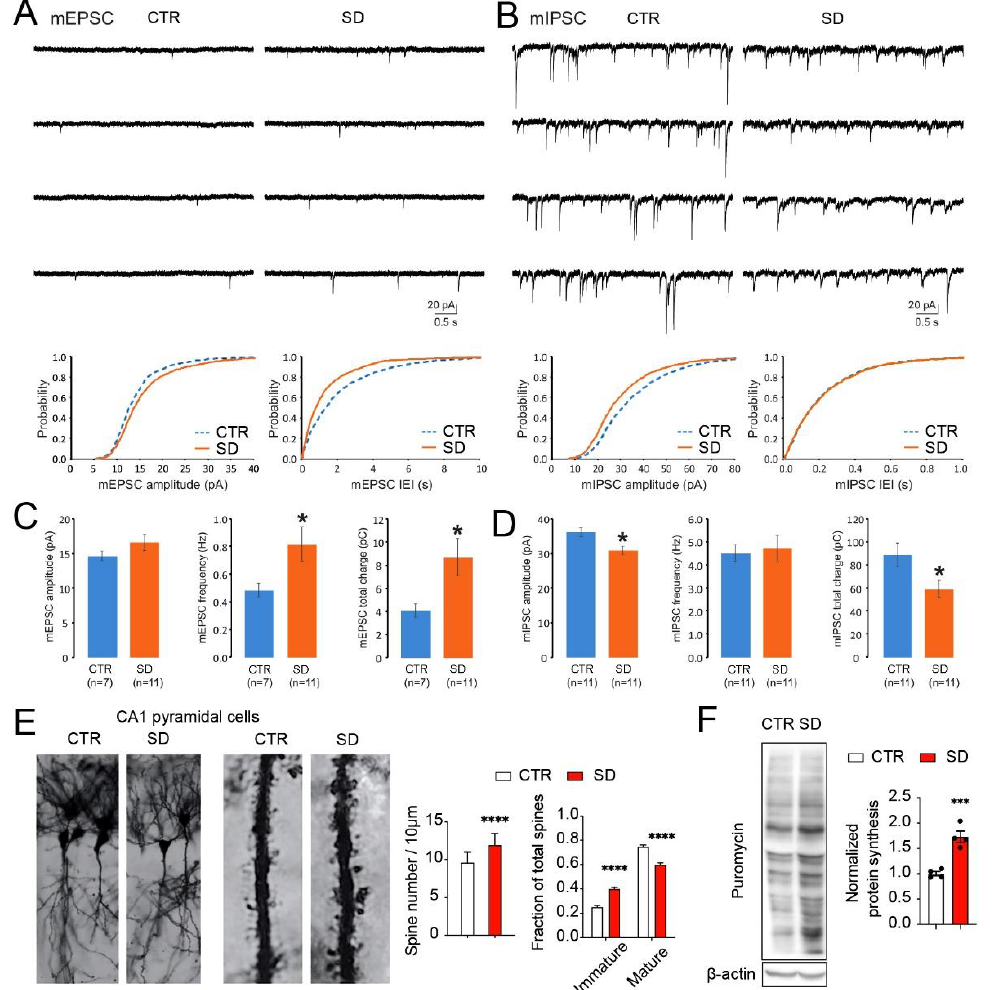
Figure 5. Aberrant synaptic transmission, dendritic spine morphology, and protein synthesis in the hippocampi of SD mice. ( A ) Representative traces and cumulative probabilities (amplitude and inter event intervals, IEIs) of mEPSC recordings from hippocampal CA1 neurons. Quantitative analysis is shown below and in ( C ). * p < 0.05 vs. CTR. Note that the frequency and total charge, but not the average amplitude, were increased in the hippocampal CA1 neurons of SD mice compared with CTR mice. ( B ) Representative traces and cumulative probabilities (amplitude and inter event intervals, IEIs) of mIPSC recordings from hippocampal CA1 neurons. Quantitative analysis is shown below and in ( D ). * p < 0.05 vs. CTR. Note that the amplitude and total charge, but not the frequency, were decreased in the hippocampal CA1 neurons of SD mice compared with CTR mice. The frequency is the reciprocal of IEI. The total charge is the summation of the area integrals of mEPSCs (in a 3-min recording period) or mIPSCs (in a 1-min recording period). n denotes the number of neurons from >3 mice for each group. ( E ) Representative microscopic images of CA1 pyramidal neurons and dendritic spines afterGolgi–Cox staining. Quantitative analysis indicates that spine density and the fraction of immature dendritic spines were increased in dendrites of hippocampal CA1 neurons in SD mice compared with the CTR mice. Data are displayed as mean ± SEM. **** p < 0.0001; n = 51 neurons from 4 mice for CTR and SD groups. ( F ) A de novo protein synthesis assay by puromycin incorporation revealed the higher rate of global protein synthesis in the forebrains of SD mice compared with CTR mice. *** p < 0.001, n = 4 for CTR and SD mice.